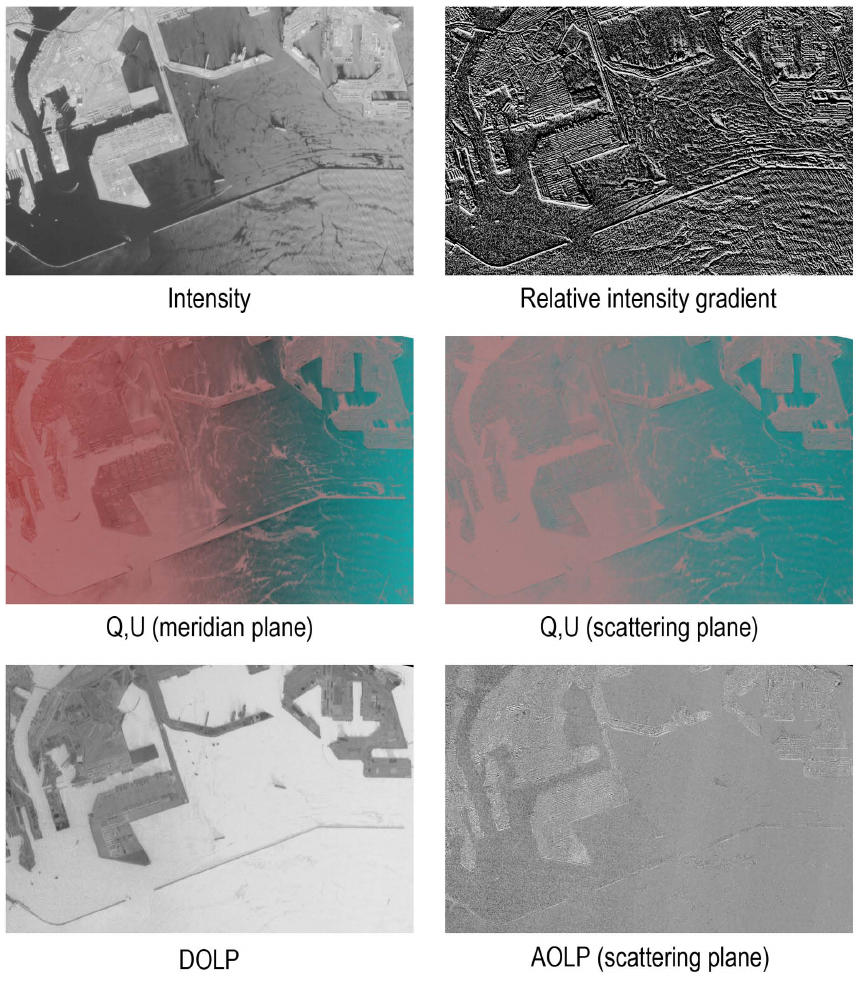
Fig. 6. Ports of Los Angeles/Long Beach data acquired 26 October 2010. Images are from the 26 ◦ aftward view at 865nm. The area shown measures 8.7km × 5.7 km. Spatial resolution is 10m. The “ Q , U ” images are false color composites in which Q and U are displayed in shades of red and cyan, respectively. Two versions are shown, one defined with respect to the view meridian plane, the other defined with respect to the scattering plane. AOLP derived from the latter takes on values very close to 90 ◦ . Sunglint results in high values of DOLP over the